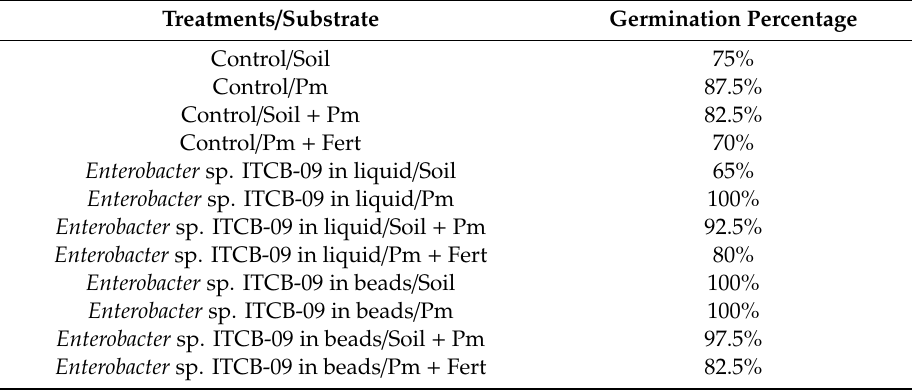
Table 5. Germination percentage of seedlings Capsicum chinense Jacq. after 15 days.